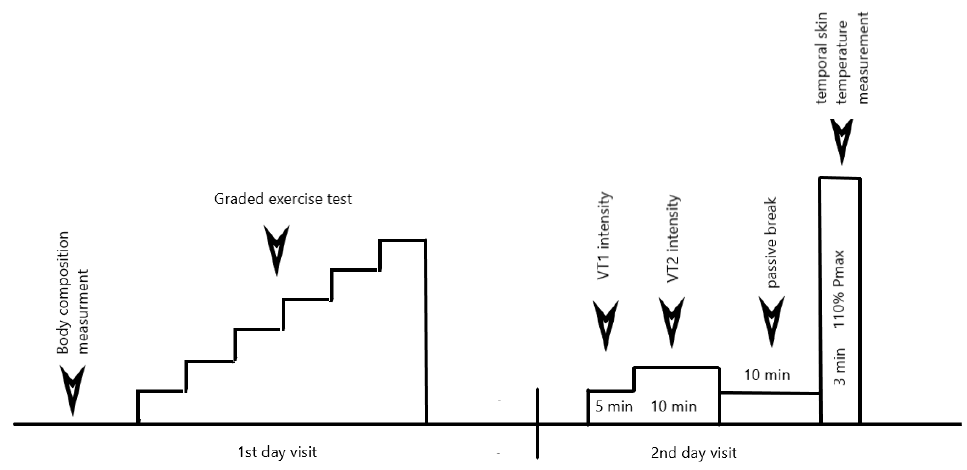
Figure 1. Scheme of visit in laboratory.